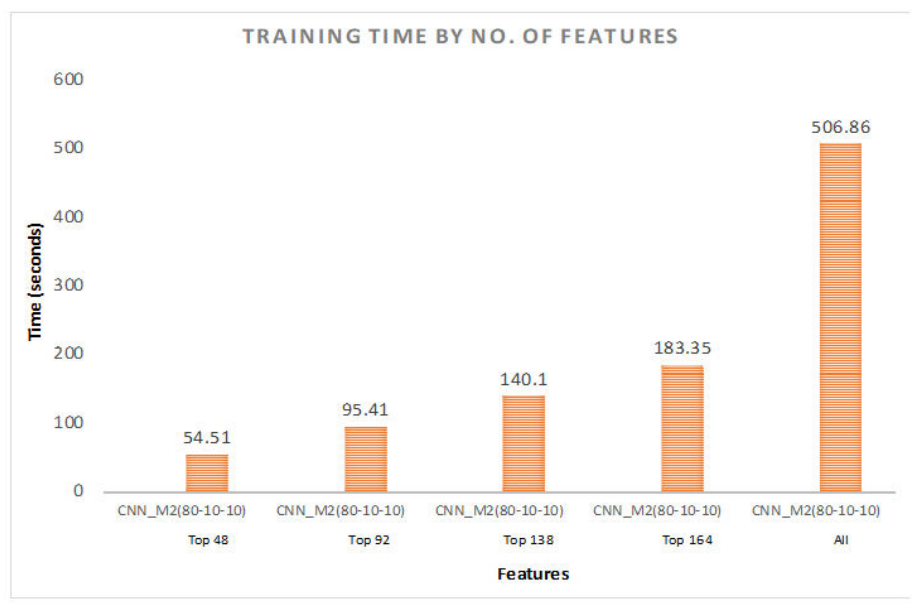
Figure 20. Training time by number of features for 80–10–10%.